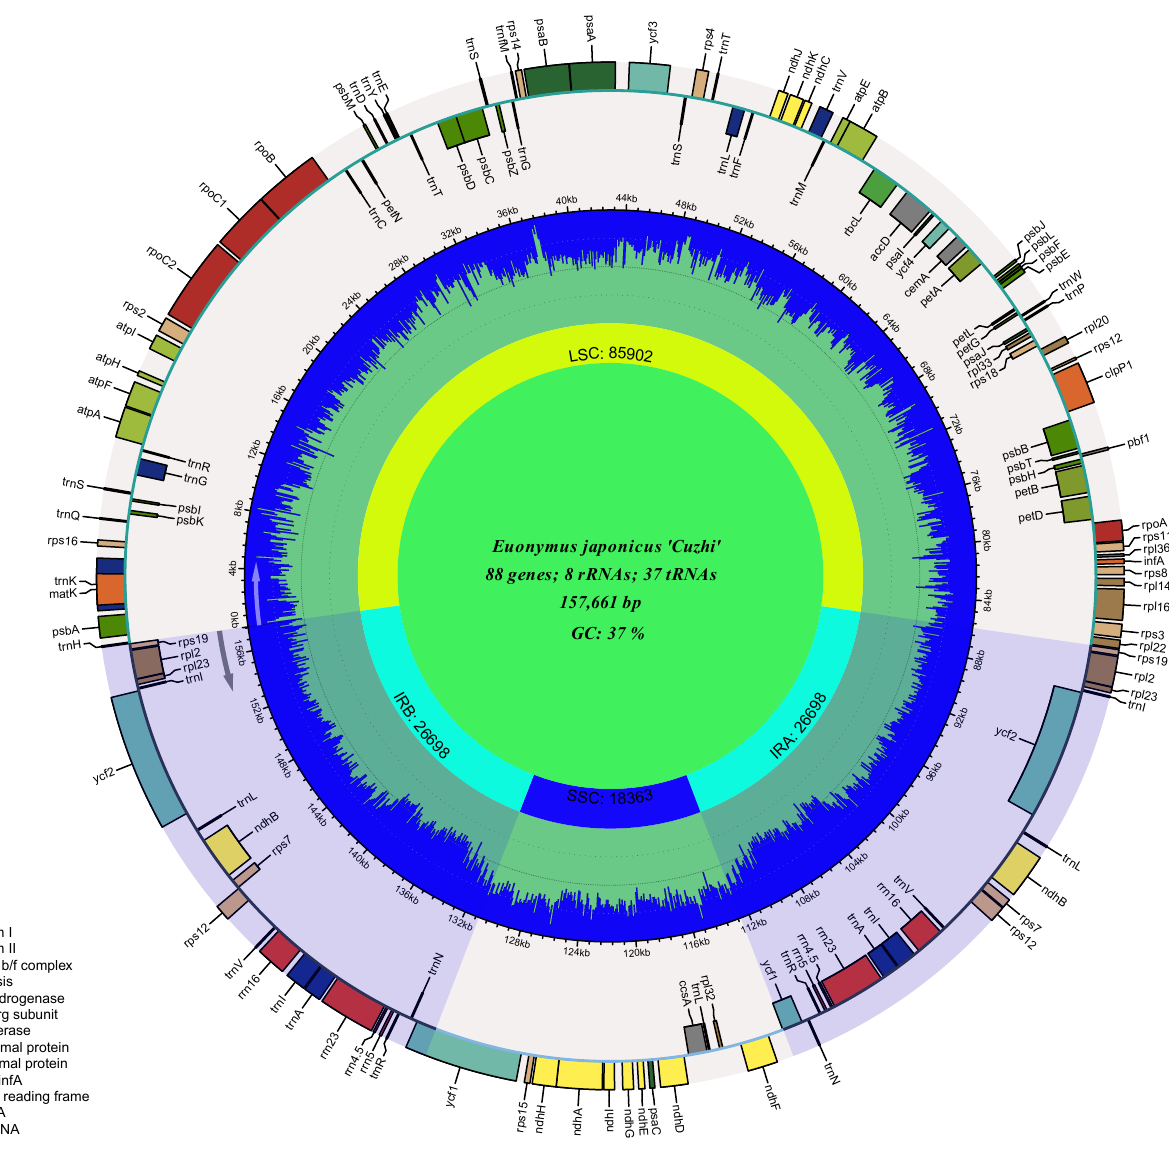
Figure 7. Physical map of the chloroplast genome of E. japonicus